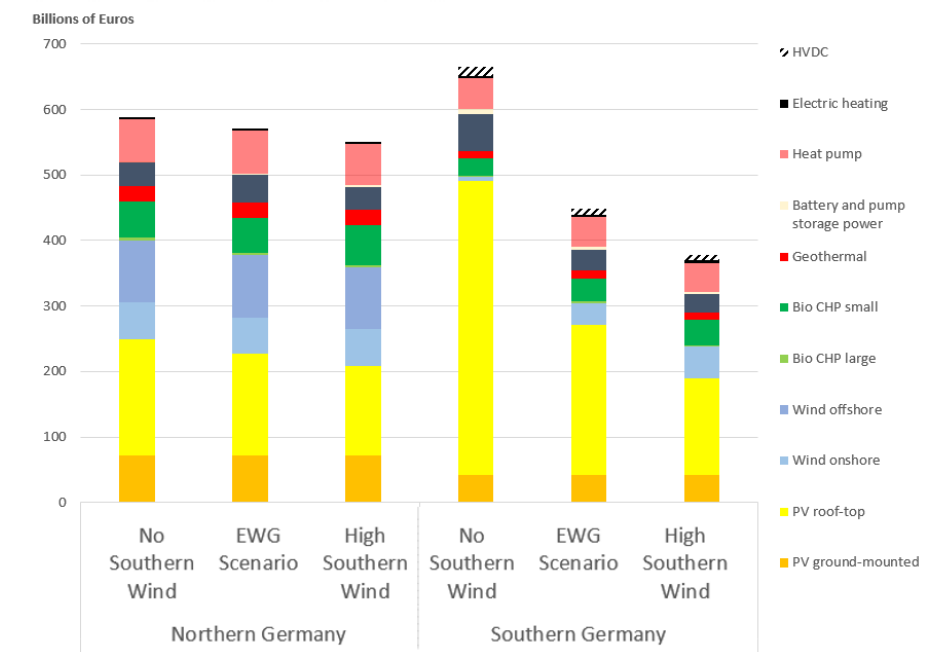
Figure A2. Total costs of energy provision over the 20–50-year lifetime of investments are greatly affected by the wind energy policy in southern Germany, where energy costs increase drastically with the renunciation of